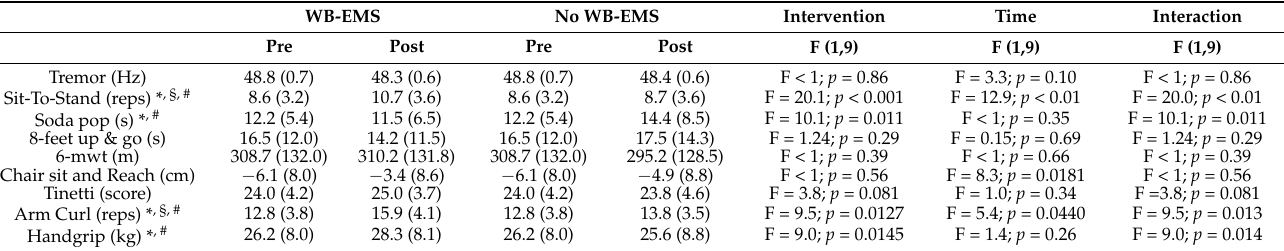
Figure 3. Physical performances: comparison between WB-EMS intervention and no WB-EMS intervention and pre- and post-assessment. * p < 0.05; reps: repetitions; kg: kilograms. Table 2. Physical assessment variables. Data as mean and